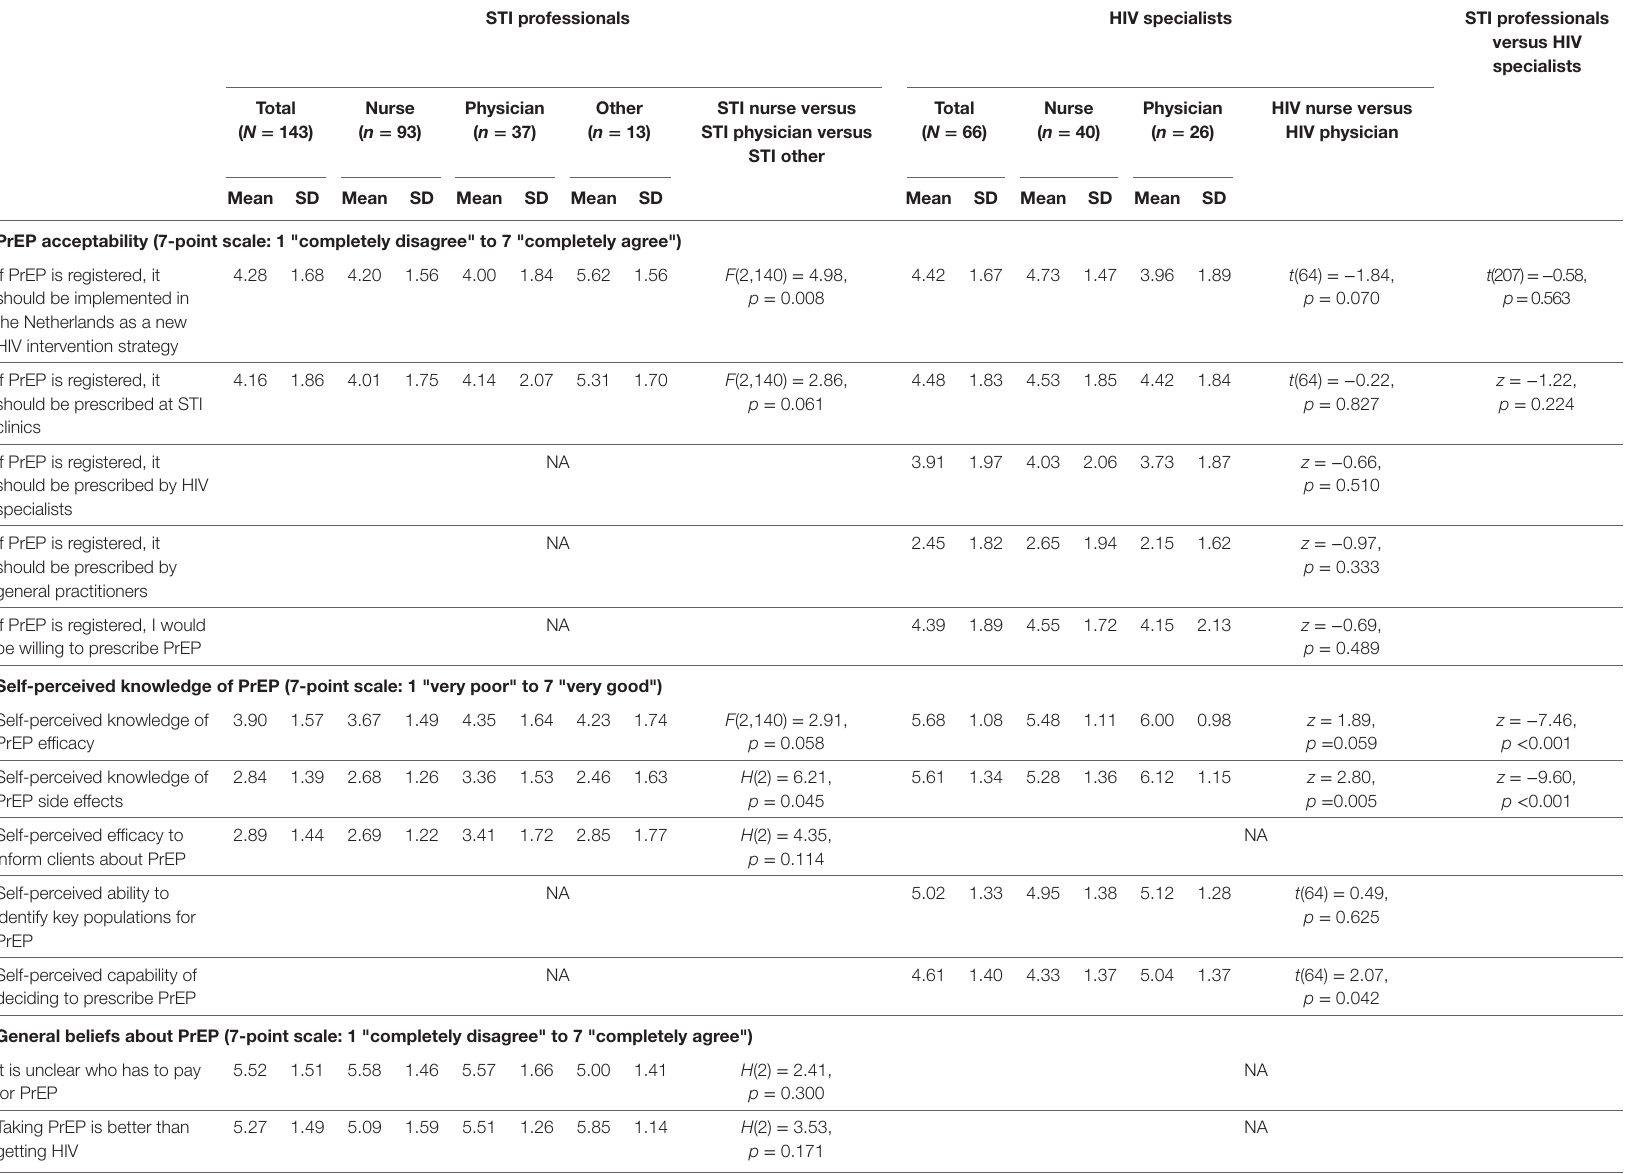
TaBle 2 | Knowledge and beliefs about PrEP among 209 health-care professionals, the Netherlands